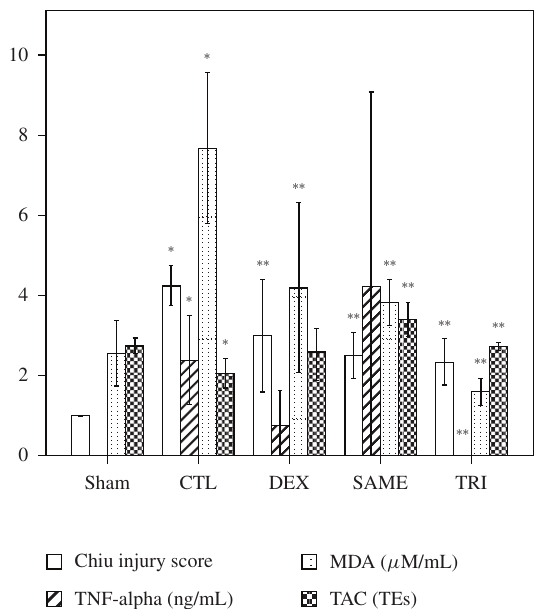
FIGURE 1: Chiu score and serum concentrations of TNF-alpha, MDA, and TAC. ∗ P < 0 . 05 versus Sham; ∗∗ P < 0 . 05 versus